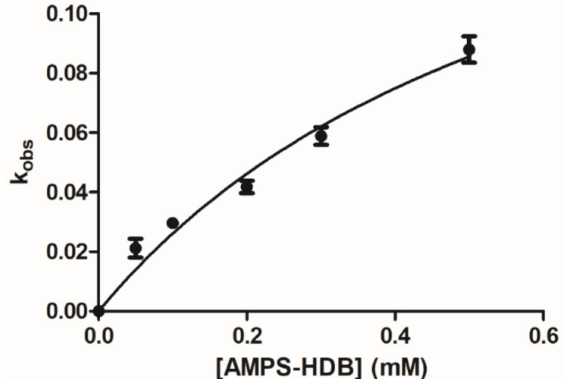
Figure 4. Dependence of the pseudo-first-order rate constant of inactivation (k obs ) on the concentra- tion of AMPS-HDB. Cb FDH was incubated with various concentrations of AMPS-HDB (0–0.5 mM) and the pseudo-first-order rate constants for the inactivation reaction were calculated from the plots as illustrated in Figure